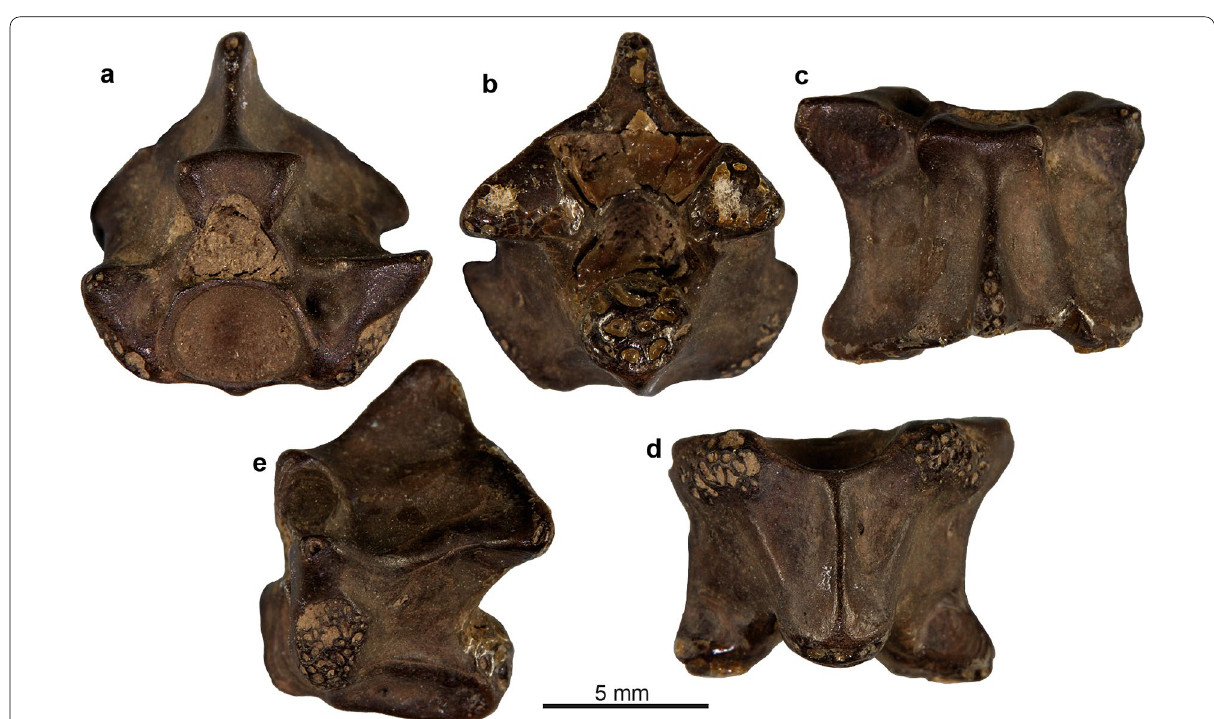
Fig. 36 Paleryx rhombifer from Hordle Cliff: mid-trunk vertebra (NHMUK PV OR 32840(1)) in anterior ( a ), posterior ( b ), dorsal ( c ), ventral ( d ), and left lateral ( e ) views. Specimen originally referred to the lizard Placosaurus margariticeps by Lydekker (1888a)